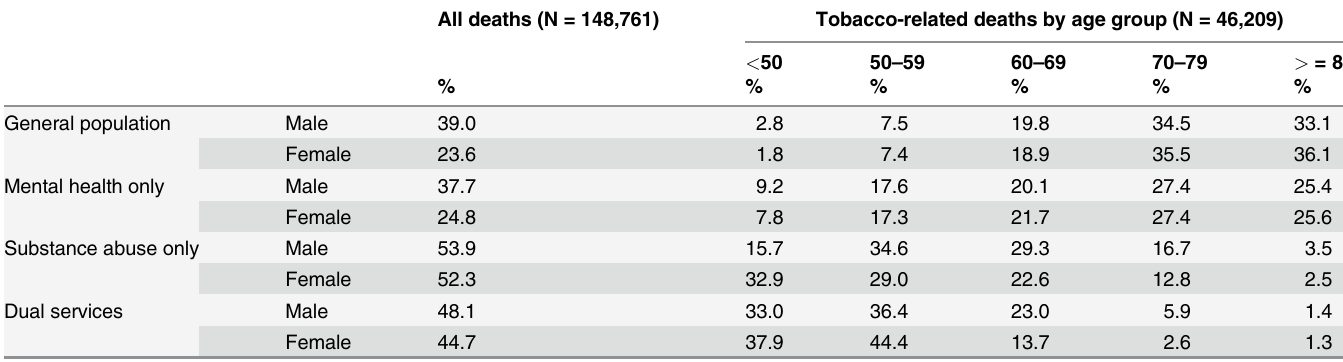
Table 4. Tobacco-related deaths by gender for persons receiving mental health and/or substance abuse services in Oregon State, 1999 – 2005 (N = 148,761) * . All deaths (N =